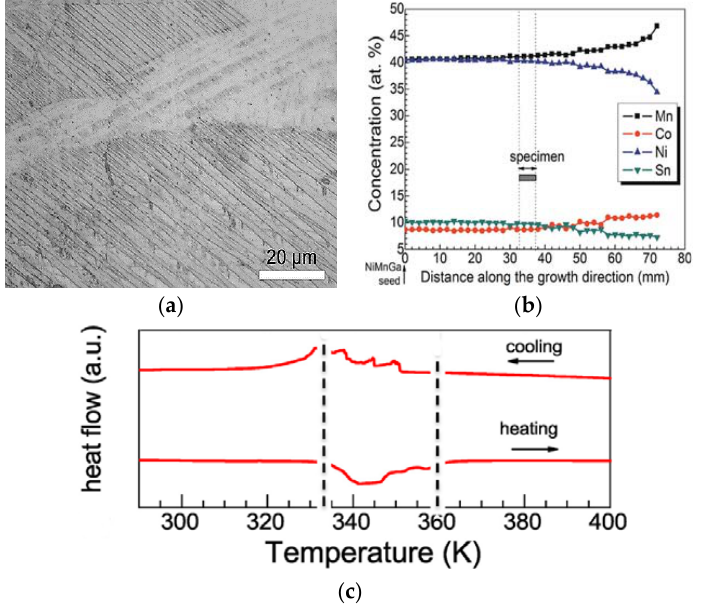
Figure 9. ( a ) Microstructure of directionally solidified alloy; ( b ) composition profile along the growth direction; ( c ) DSC curves across the structural transition [64], with copyright permission from © Elsevier BV .